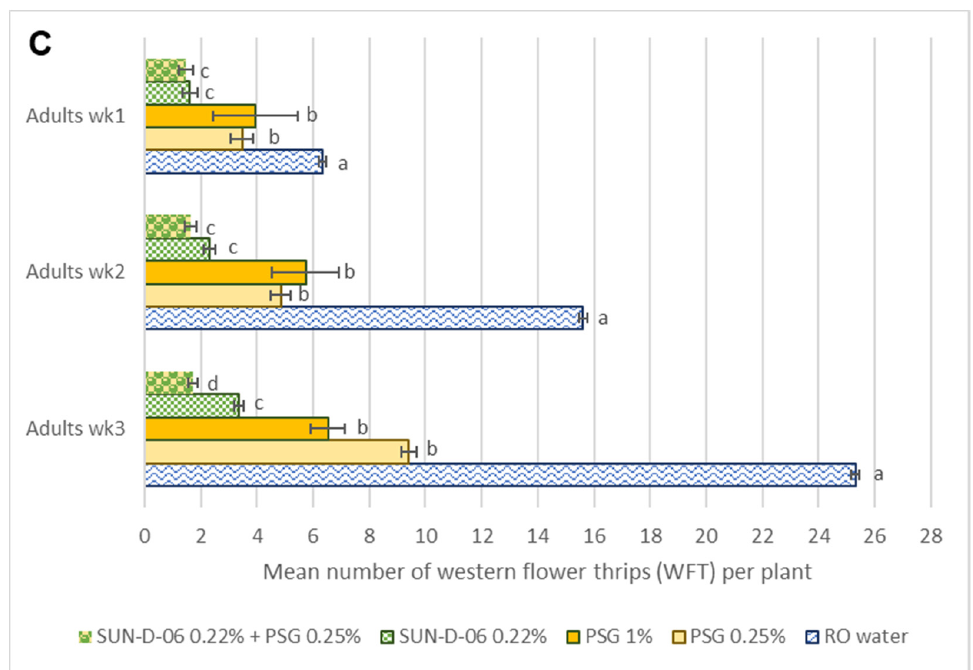
Figure 5. Mean number of western flower thrips (WFT) observed in weeks 1, 2 and 3 on pepper plants (seven days after infestation, week 1, 14 days after infestation, week 2 and 21 days after infestation, week 3). ( A )—Total WFT (all stages combined); ( B )—WFT larvae; ( C )—WFT adults. Error bars denote standard error, while bars with the same letters indicate treatments that do not significantly differ ( p > 0.05).